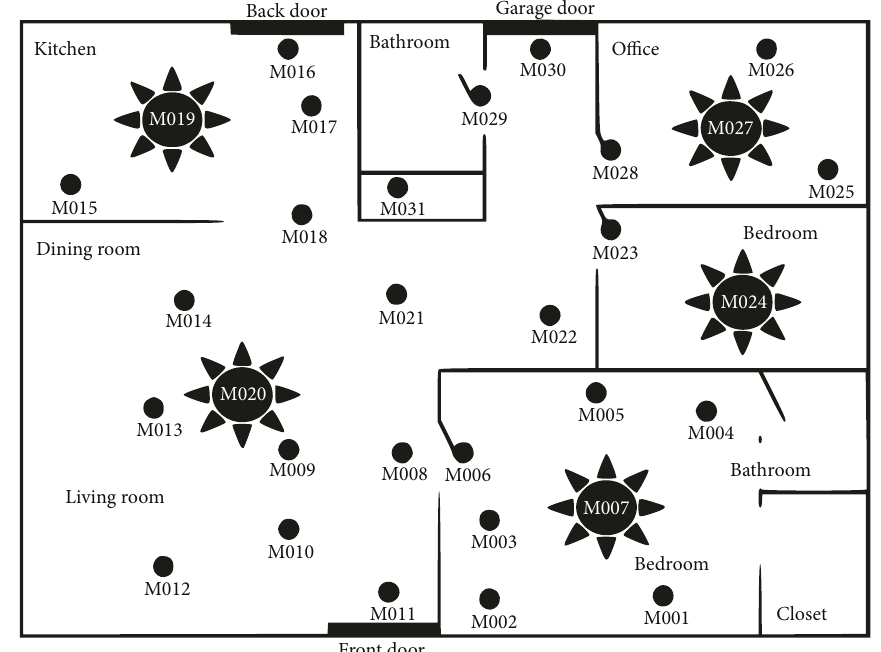
Figure 3: An example of floor plan with sensor layout used in CASAS. Each MXXX ID is a motion sensor